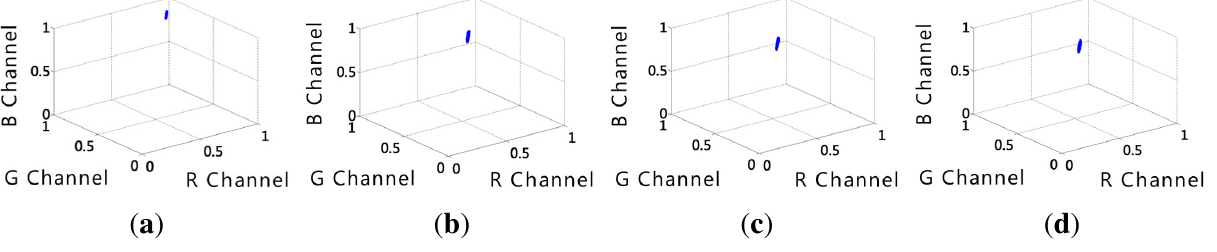
Figure 2. The distribution of the RGB color of the red rectangular regions in Figure